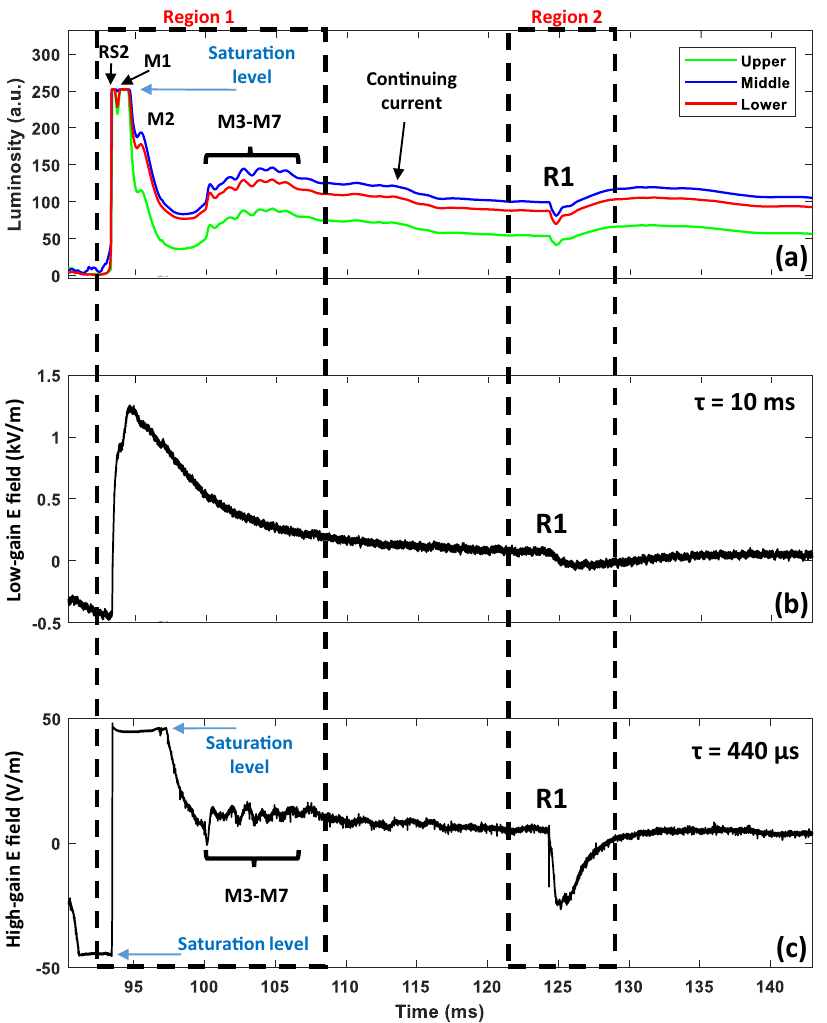
Fig. 7 Two-stroke positive Flash 2014, Stroke 2. a Luminosity variation during the second return stroke (RS2) followed by continuing current. b , c Low- gain and high-gain electric fi eld waveforms, respectively, aligned (with ± 24- µ s uncertainty) with the luminosity variation shown in a . Full time scale is 52.5 ms. M stands for M-components (events causing channel luminosity enhancements) and R is used to mark an event causing channel luminosity dip seen around 125 ms in a